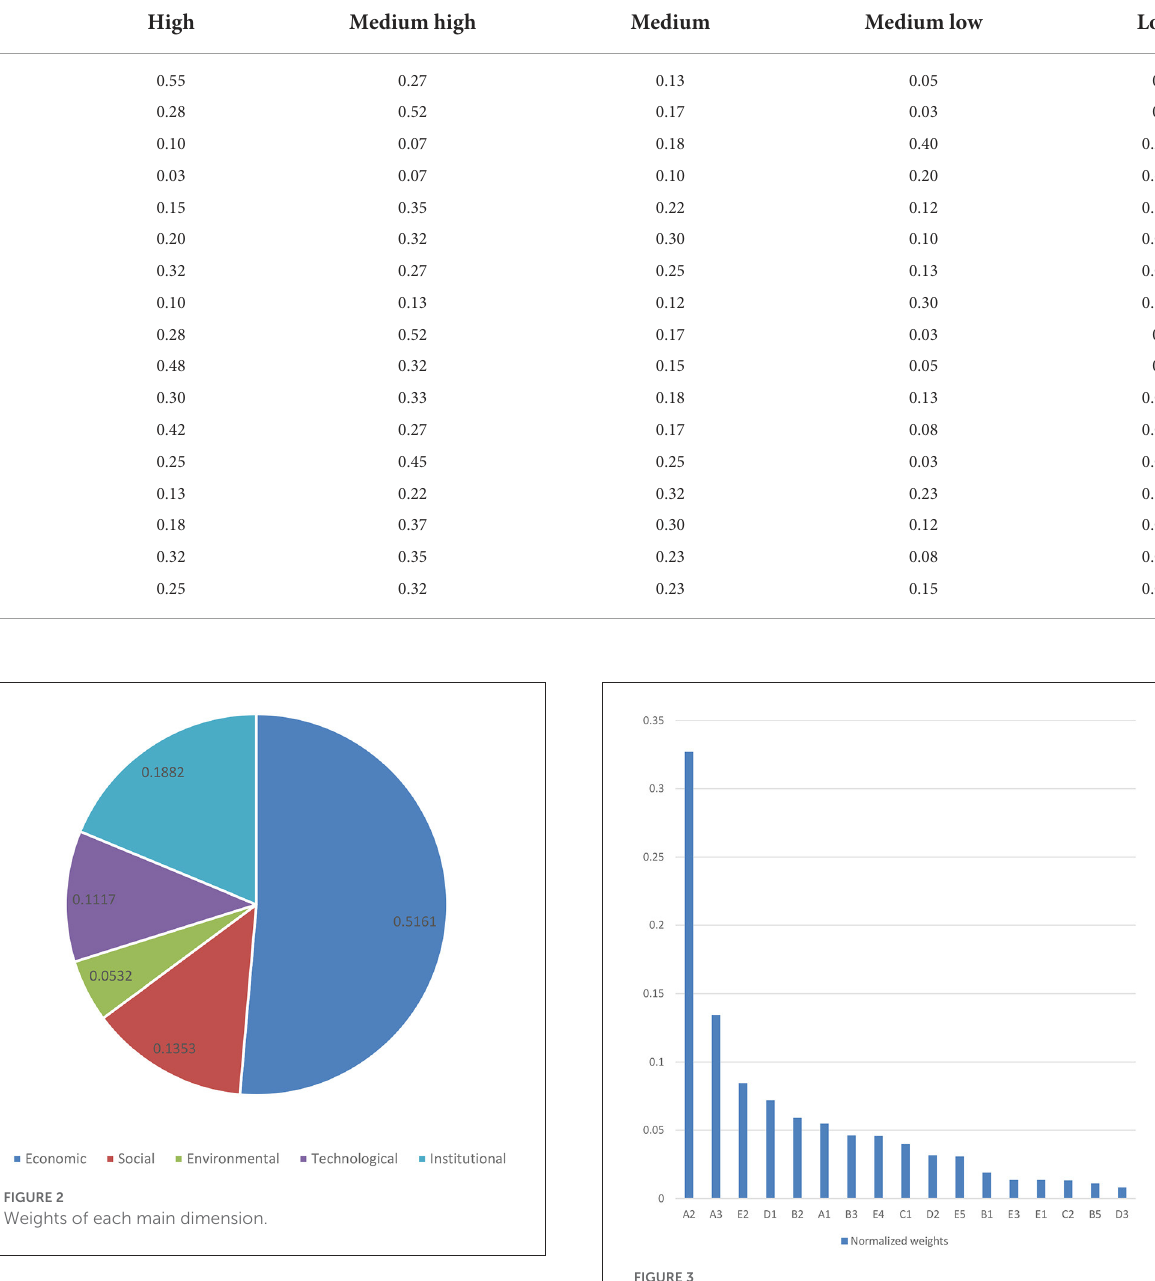
FIGURE3 Normalized weights of each